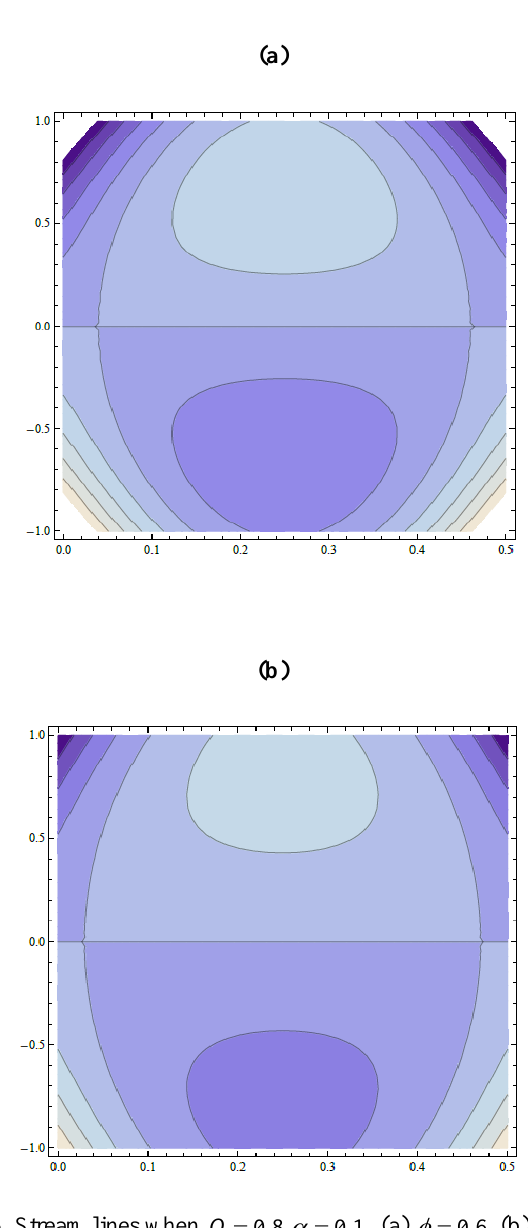
Fig. 15. Stream lines